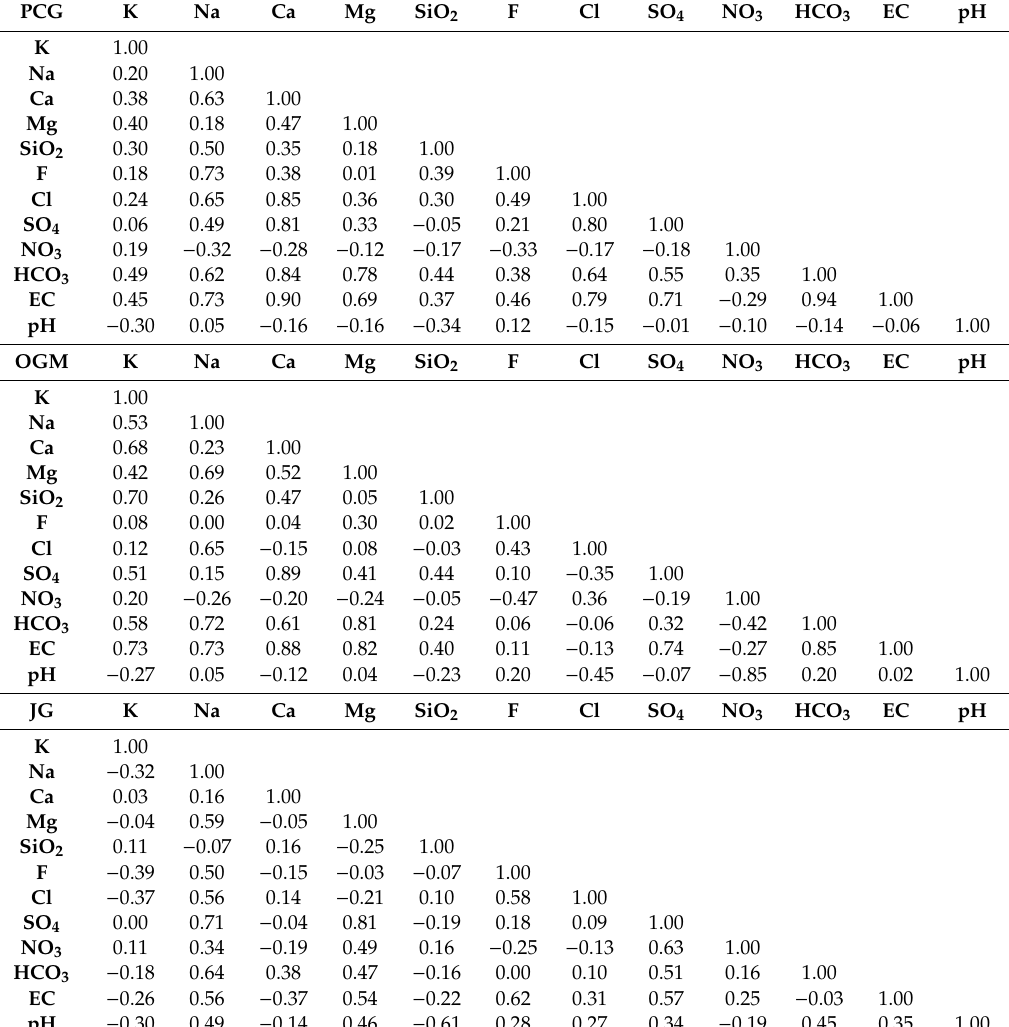
Table 2. Correlation matrix between physicochemical components in groundwater for bottled